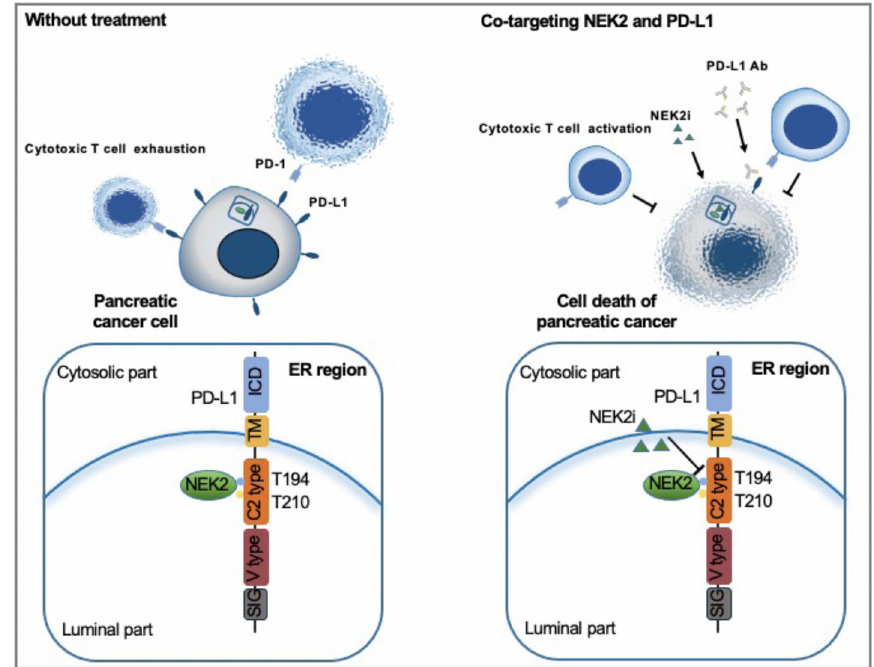
Fig. 8 Predicted model of the NEK2 – PD-L1 signaling pathway in pancreatic cancer. A schematic model is proposed to illustrate how PD-L1 protein stability is regulated by NEK2 in pancreatic cancer. NEK2 positively regulates and interacts with PD-L1 largely through PD-L1 phosphorylation at the T194/ T210 residue in ER of pancreatic cancer. Therefore, treatment with NEK2 inhibitor unexpectedly suppressed PD-L1 protein expression, largely by inhibition of PD-L1 phosphorylation that promotes its